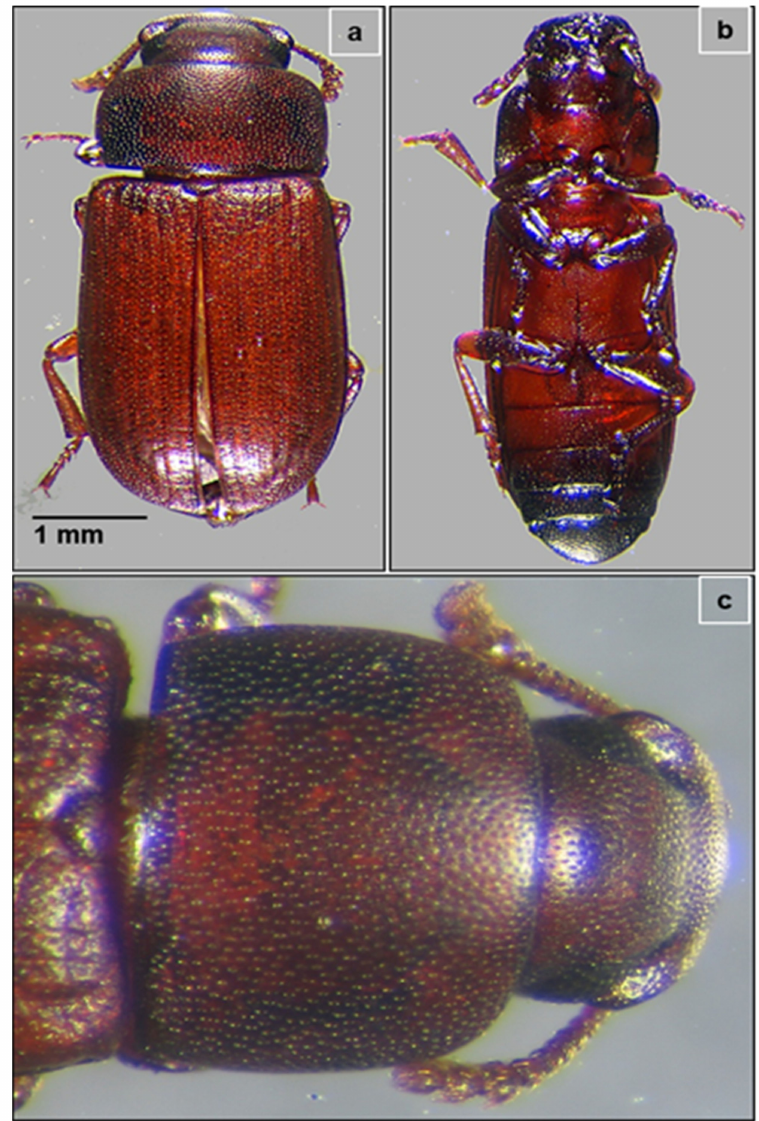
Figure 1. The red flour beetle, Tribolium castaneum. ( a ) Dorsal view showing the flattish curved- sided body covered with minute punctures. Ventral view of the whole body of adult beetle ( b ), and magnified view of the thorax with prominently large eyes and capitate antennae with broad segments ( c